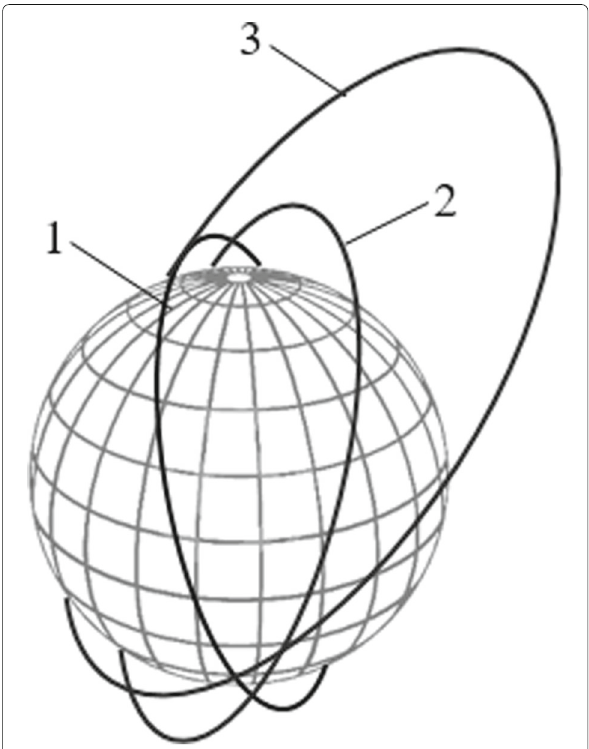
Fig. 5 The mutual arrangement of multi-satellite group orbits. The numbers mark the orbits in the order presented in the above